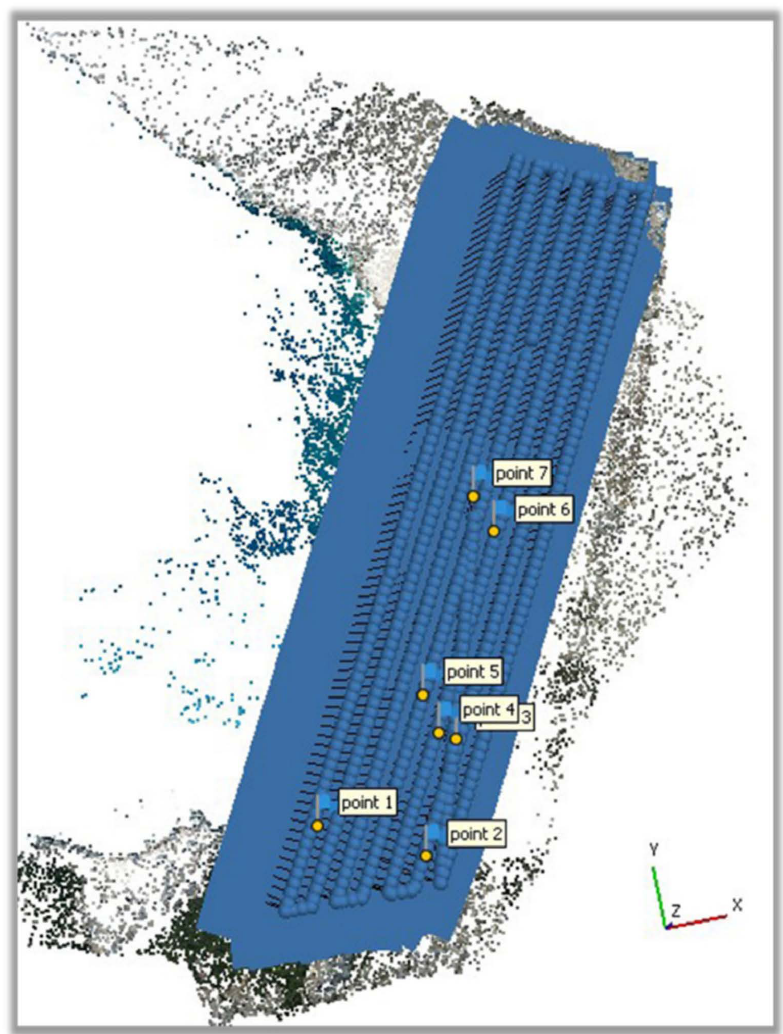
Figure 9. Sparse point cloud showing the UAS camera locations during the image acquisition and the position of the seven